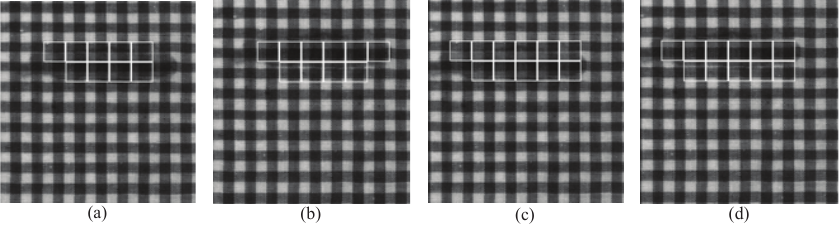
Figure 12. Defective blocks identified from the image cropped from (a) top-left (b) bottom-left (c) top-right and (d) bottom-right corners of the input image. Boundaries of the defective periodic blocks are highlighted with white pixels.